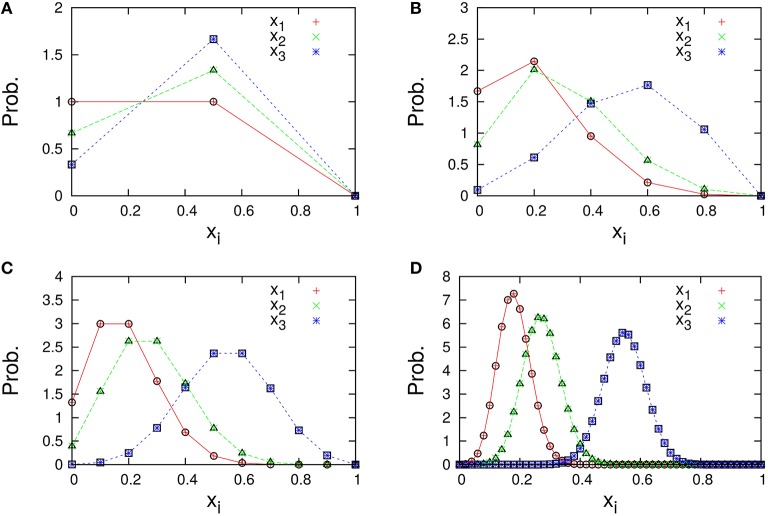
Marginal distributions of xi = ni/N (i = 1, 2, 3) in the three-species system of Figure 1A. The total number of molecules in each figure is (A)
N = 2, (B)
N = 5, (C)
N = 10, and (D)
N = 50. Cross symbols (red, green, blue) represent the simulation results obtained numerically using the Gillespie algorithm (Gillespie, 1977), which is performed under the following condition; the total number of reactions: 108, the number of reactions for transient exclusion: 107, and the initial value (n1(0), n2(0), n3(0)) is randomly selected from W \ I such that the average per one-species is N/M. Empty symbols (circle, triangle, square) represent the theoretical expression Npi*c(Nx) [Equation (44)] for λ1 = 2/11, λ2 = 3/11, and λ3 = 6/11.